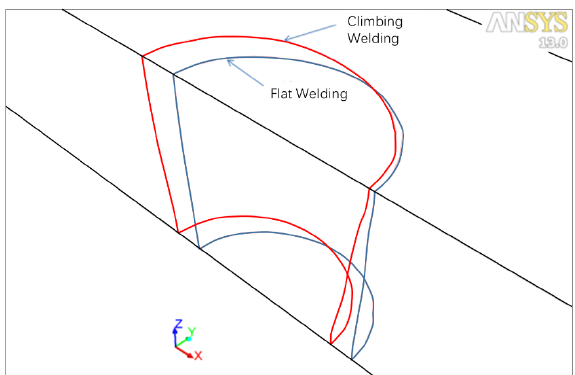
Figure 7. Comparison of the weld pools for flat and climbing welding positions.